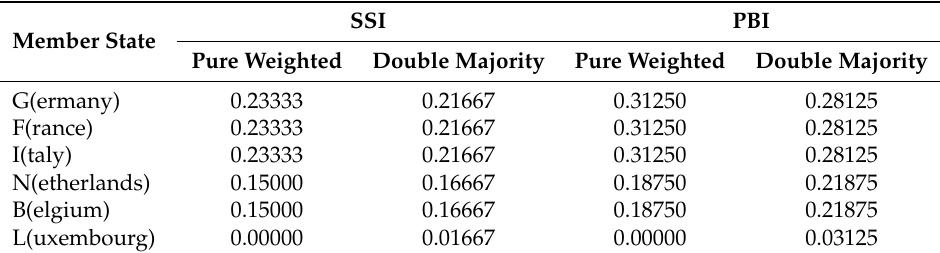
Table 1. SSI and PBI in 1958–72 CM under pure weighted and double majority